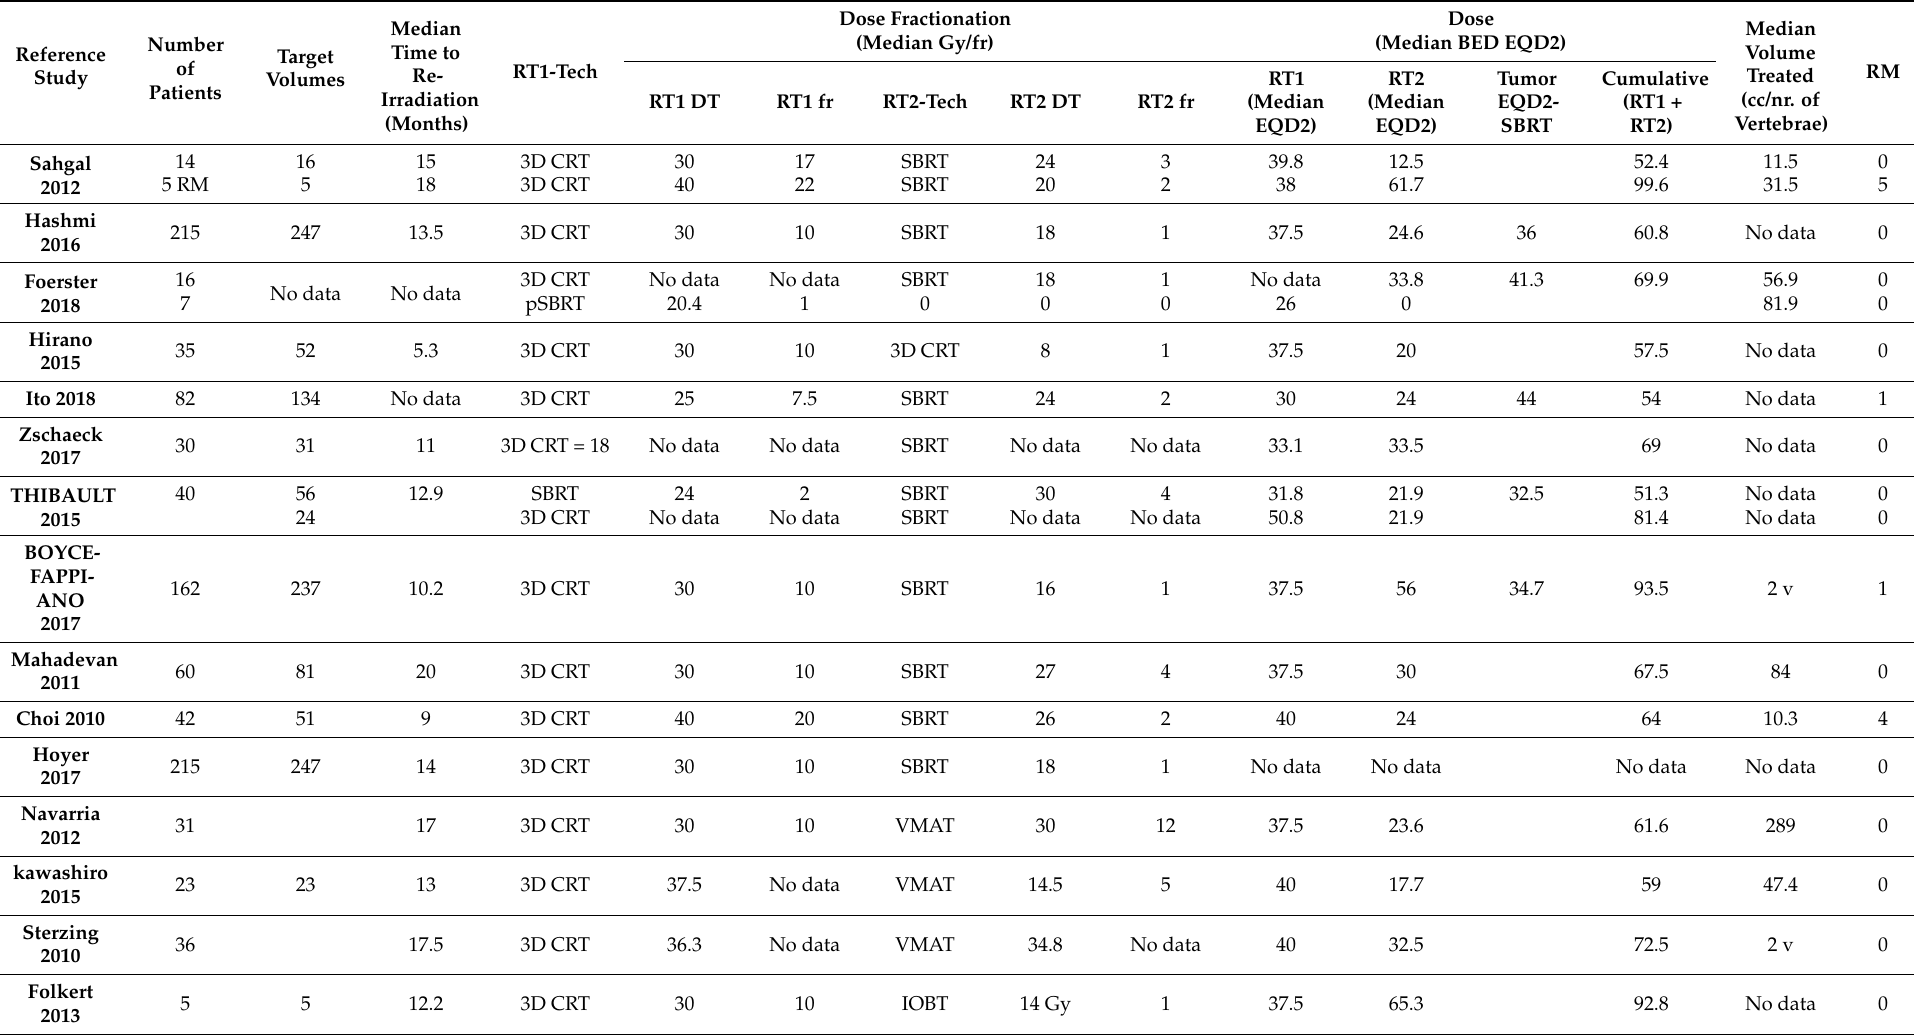
Table 1. Technique and dose fractionation for first and second radiotherapy cycle; cumulative doses normalized to